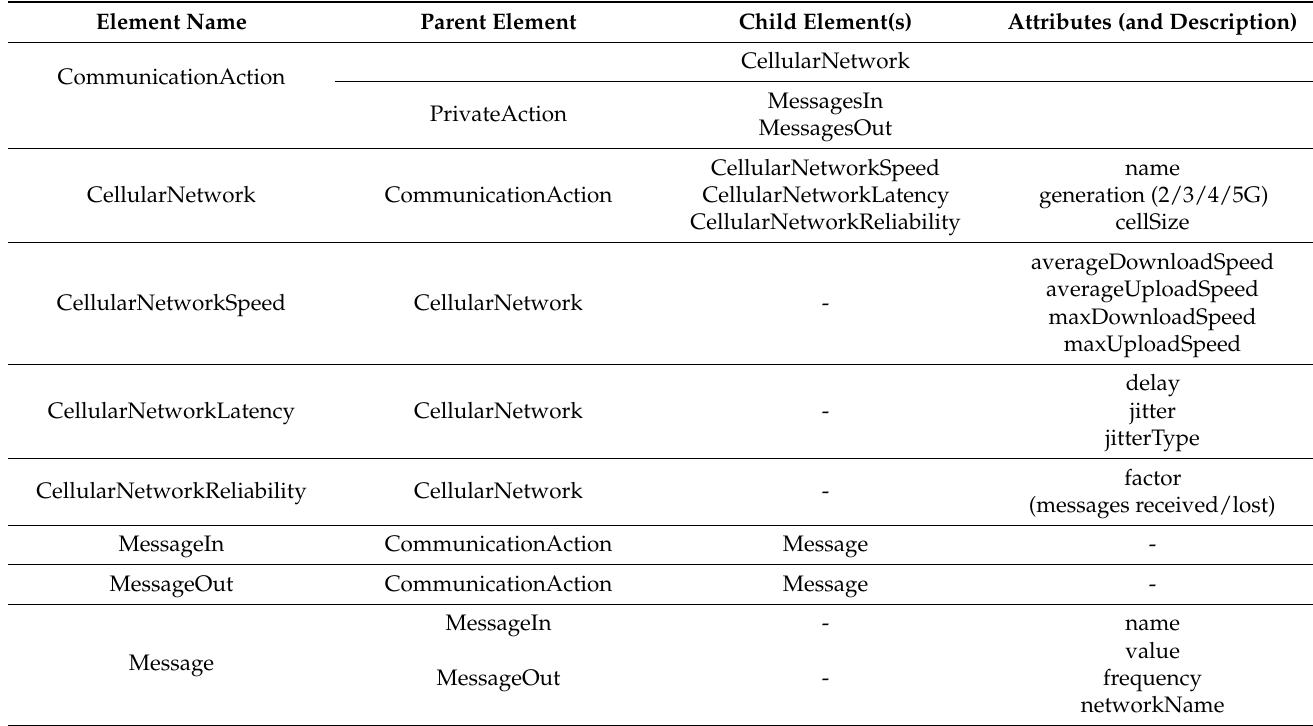
Additional OpenSCENARIO element definitions to enable inclusion of I2V communication in the OpenSCENARIO